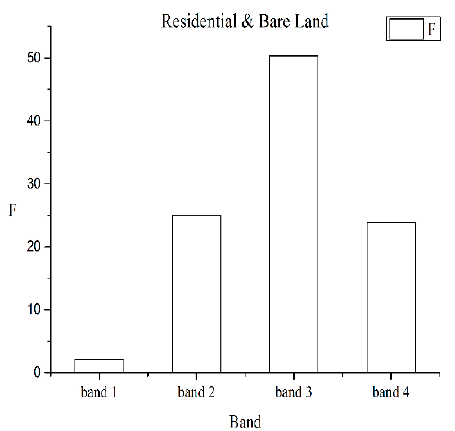
Figure 8. Comparison of differences in the mean grey value of each band for residential and bare land.